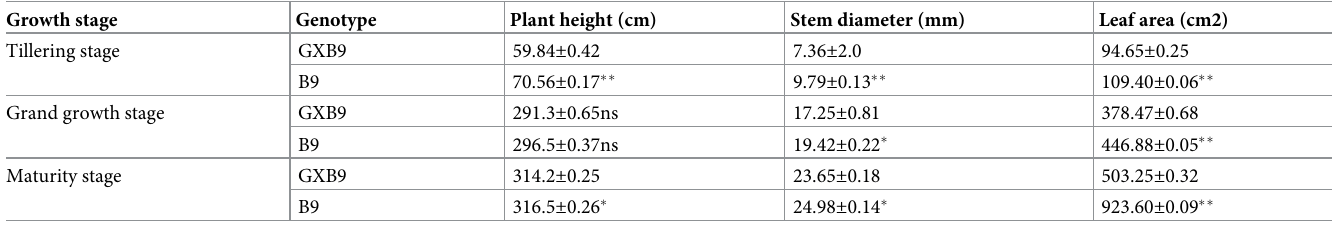
all the growth stages (Fig 9A and 9B). The concentration of GA was recorded with no signifi- cant difference between the two clones at tillering stage and maturity stage, however, it was sig- nificantly higher at grand growth stage in GXB9 than B9 (Fig 9C). The cytokinin (CYT) quantity was significantly higher in B9 than GXB9 at tillering stage, but not significantly differ- ent at later stages (Fig 9D). Relative expression of selected genes analyzed with qRT- PCR . The relative expressions of selected genes in the maturing and immature internodes were analyzed at maturity stage. The results showed that genes encoding enzymes such as SPS (SPS5), SuSy, CWIN and CeS were Table 4. Plant height, stem diameter and leaf area in GXB9 and